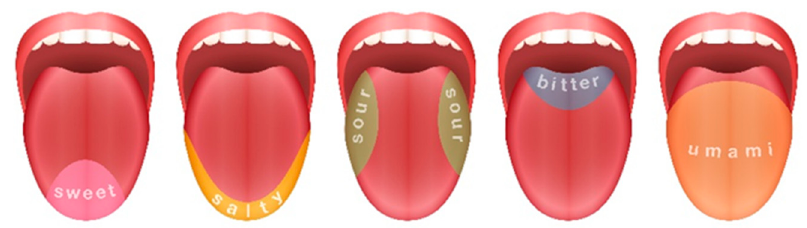
Figure 1. Scheme of human tongue and taste receptors